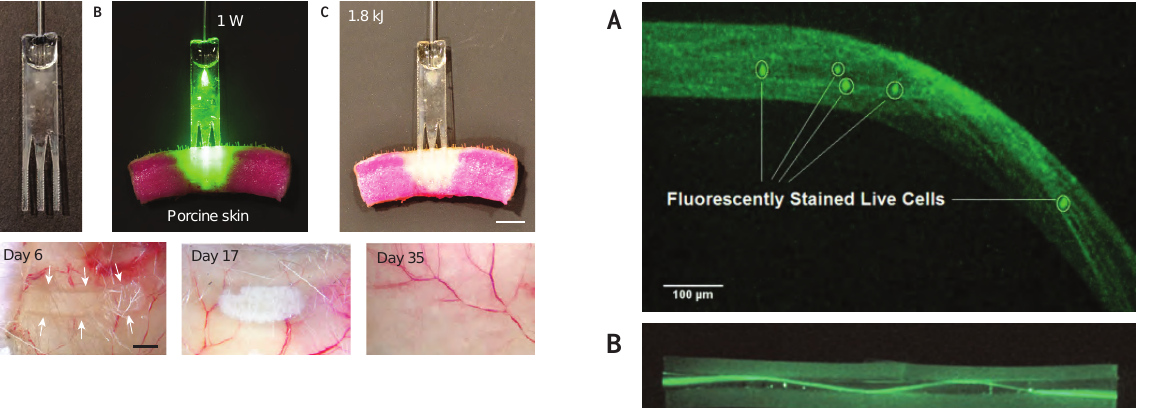
Fig. 5. Biodegradable synthetic polymer waveguides. (A) Planar comb-shaped PLA optical waveguide connected to an optical fiber. (B) Delivery of light through the waveguide deep into the skin tis- sue. (C) Photobleaching of an applied dye indicates the area of light penetration. (D) Biodegradation of a piece of PLA waveguide in vivo during 35 days. Reprinted by permission from [136], Copyright 2016, Macmillan Publishers Ltd.